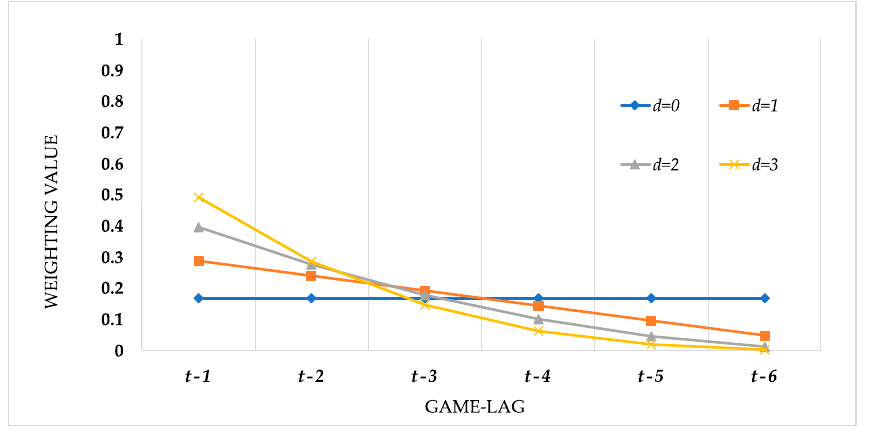
Figure 5. Weighting distribution of each data point with different weighting control parameter ( d ) from 0 to 3 under game-lag = 6.